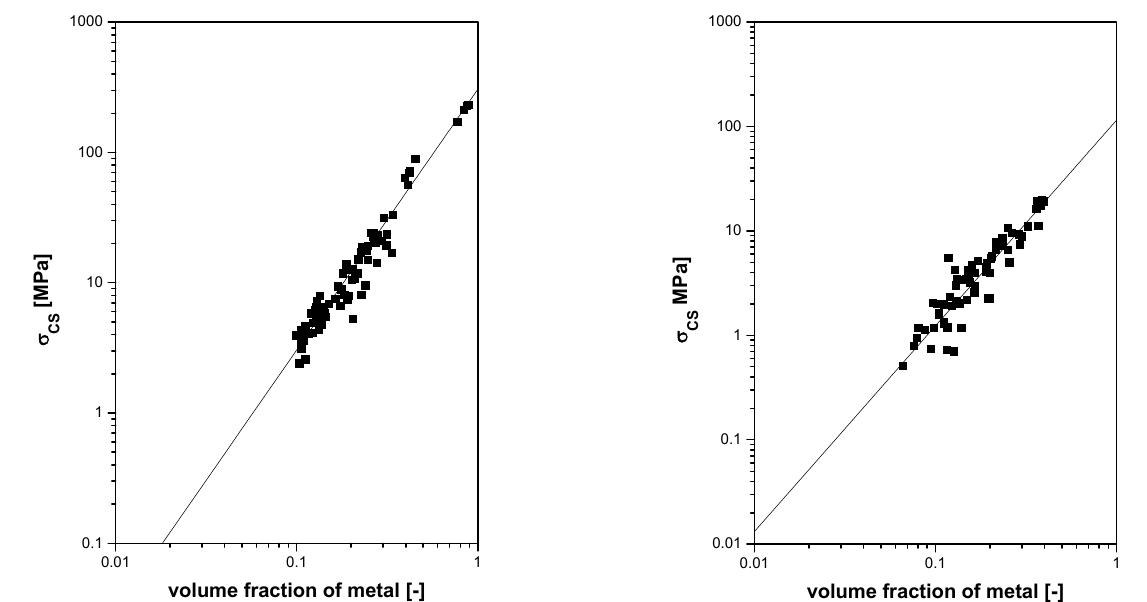
Figure 3: Scaling of the compression strength for AlMg1Si0.6 foam without surface skin  20 x {10, 20, 30, 40} mm 2